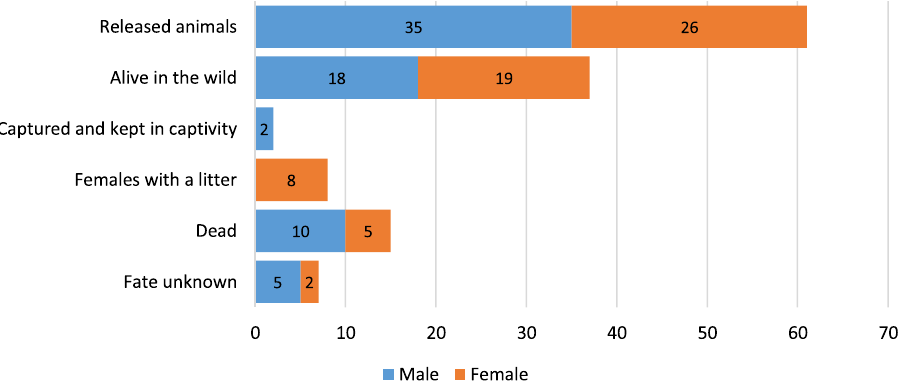
Figure 1. Summary of the fate of Eurasian lynx (N = 61) released during a reintroduction project in north- western Poland, as of 30 September